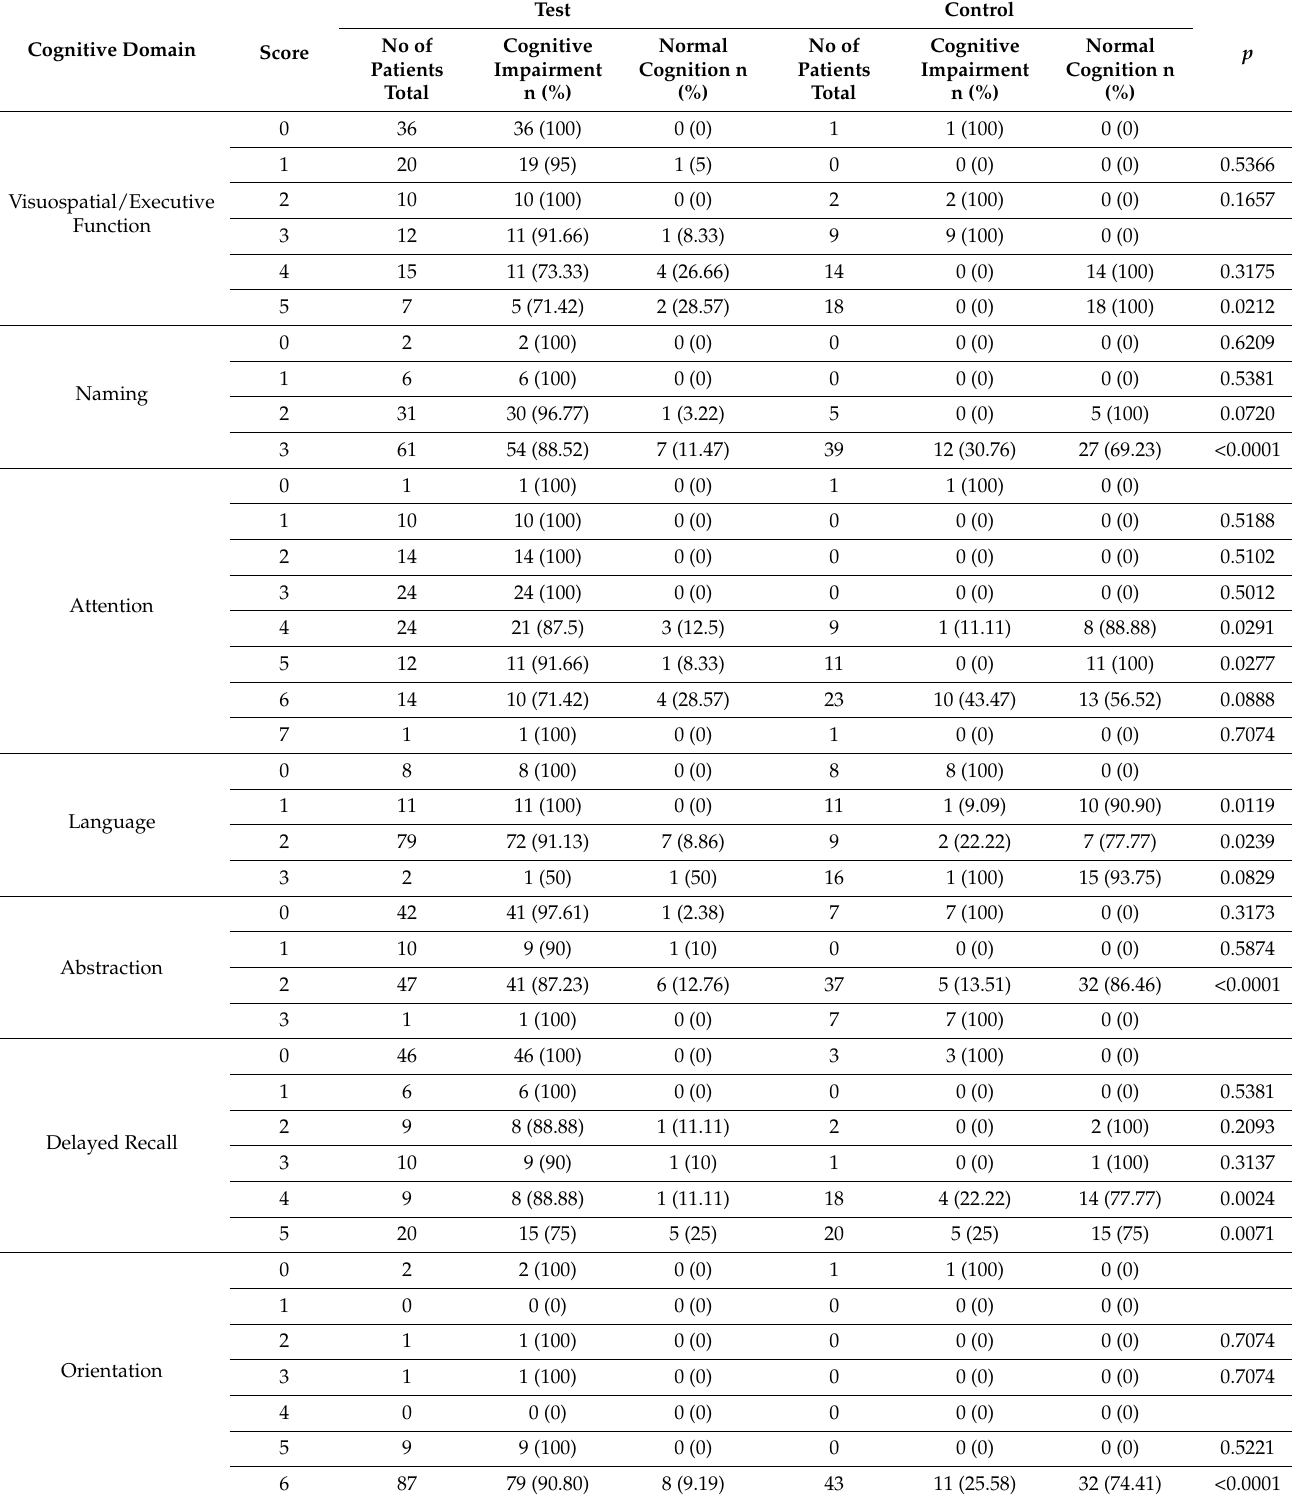
Table 5. The proportion of participants showing cognitive impairment or normal cognition concerning their scores in each cognitive